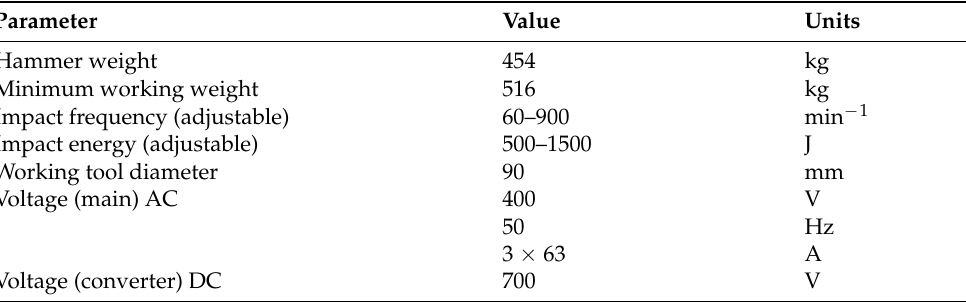
Table 4. Technical parameters of Lekatech electric hammer (LEH)